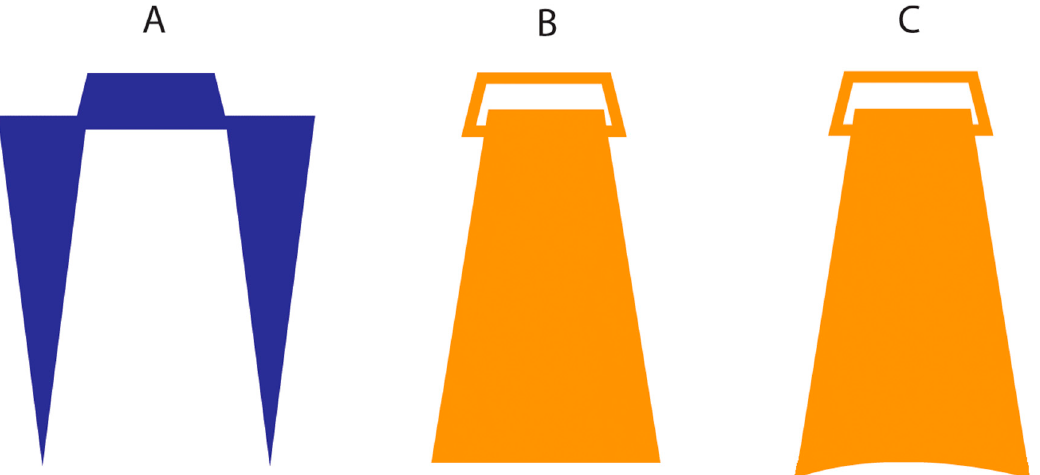
Figure 1. Schematic representation of the stimuli used in the three experiments: ( A ) posts, ( B ) flat and ( C ) curved objects’ surface. Note that the stimuli in panel ( A ) were used in all experiments. Stimuli in panel ( B ) were used for both the across and along stimulations in Experiment 1. In Experiments 2 and 3, stimuli in panel ( B ) were used for the along stimulation and stimuli in panel ( C ) for the across stimulation.